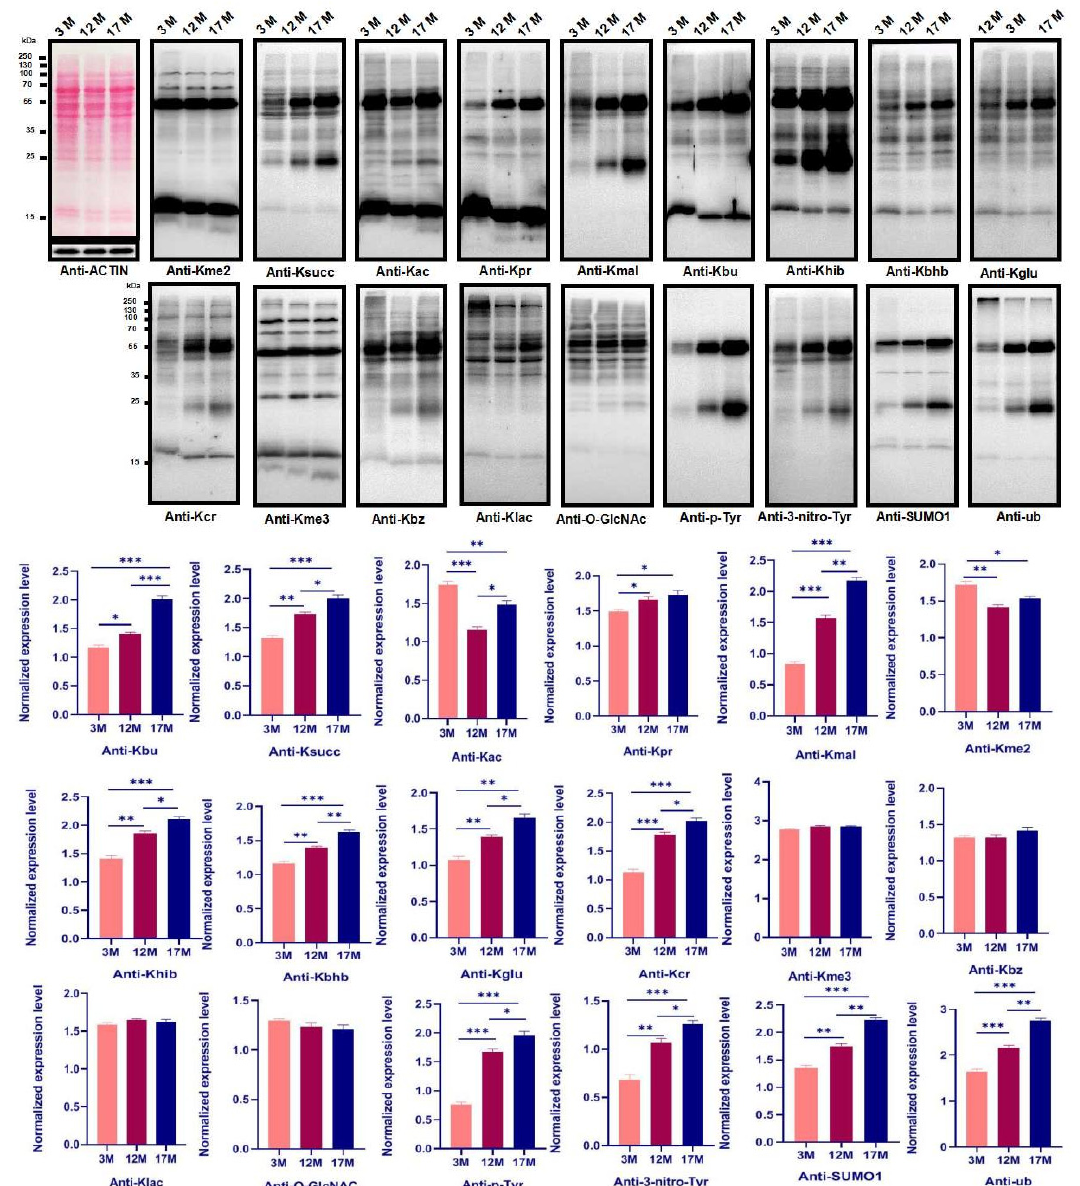
Figure 2. The global profiles of post-translational modifications (PTMs) during physiological ovarian aging in the mouse ovaries. Ovaries proteins in different age of mice were isolated and the global level of PTMs was examined by western blot and analyzed by quantifying the sum of the gray values of detected bands normalized to those of b-ACTIN using Image J software (version1.44, National Institutes of Health, Bethesda, MD, USA). Kme2, lysinedi-methyllysine; Kme3, lysinetri--methyllysine; Kac, lysineacetyllysine; Kpr, lysinepropionylation; Kmal, lysinemalonylation; Kbu, lysinebutyryllysine; Khib, lysine2-hydroxyisobutyrylation; Kbhb, lysine β -hydroxybutyryllysine; Kcr, lysinecrotonylation; Ksucc, lysinesuccinylation; Kglu, lysineglutarylation; Kbz, lysinebenzoylation; Klac, lactyllysine; P-Typ, phosphotyrosine; 3-nitro-Tyr, nitro-tyrosine; SUMO1, SUMO1 modification; ub, ubiqutin; O-GlcNAc, O-GlcNAcylation. Bar: mean ± SEM, * p < 0.05, ** p < 0.01, *** p < 0.001.